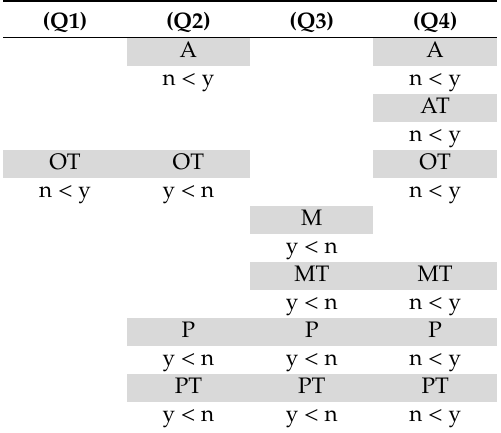
Table 8. Rankings of user characteristics (answers to Q1, Q2, Q3 and Q4) from low to high ratings for every instruction type, resulting from pairwise one-tailed Mann-Whitney U